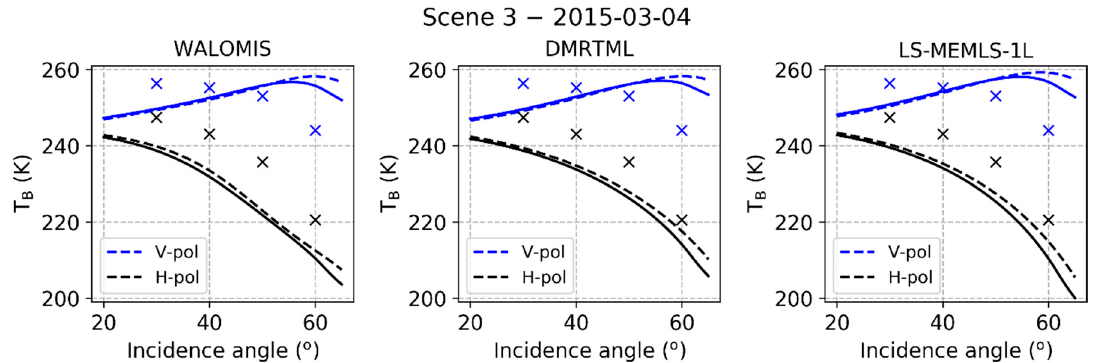
Figure 6. T B V-pol (blue) and T B H-pol (black) measured (symbols) and simulated using non-weighted (dashed) and weighted (lines) signal within the footprint; with WALOMIS ( left ), DMRT-ML ( center ) and LS-MEMLS-1L ( right ) at Scene 3 for March 4th, 2015.